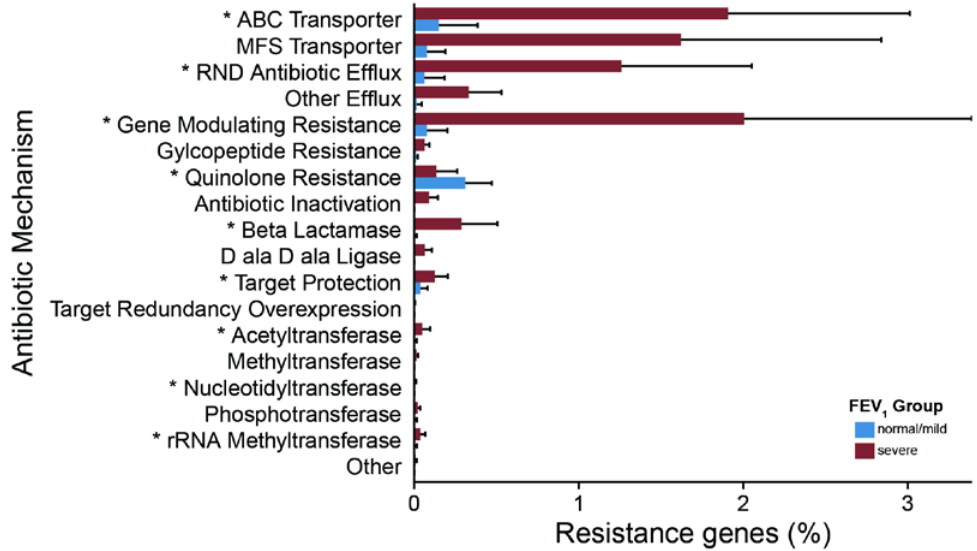
Figure 5. Antibiotic resistance gene differentiate patient groups. Bar charts report the percentage values of antibiotic resistance gene detected. Significant differences are reported with one asterisk ( p -value < 0.05). P values were obtained through a Student’s t -test on the number of genes detected. Bars were drawn by computing the average percentage value of each resistance category whereas error bars are reported using standard errors.